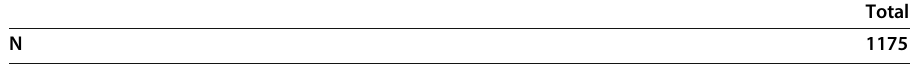
Table 1 Frequency distribution of independent variables